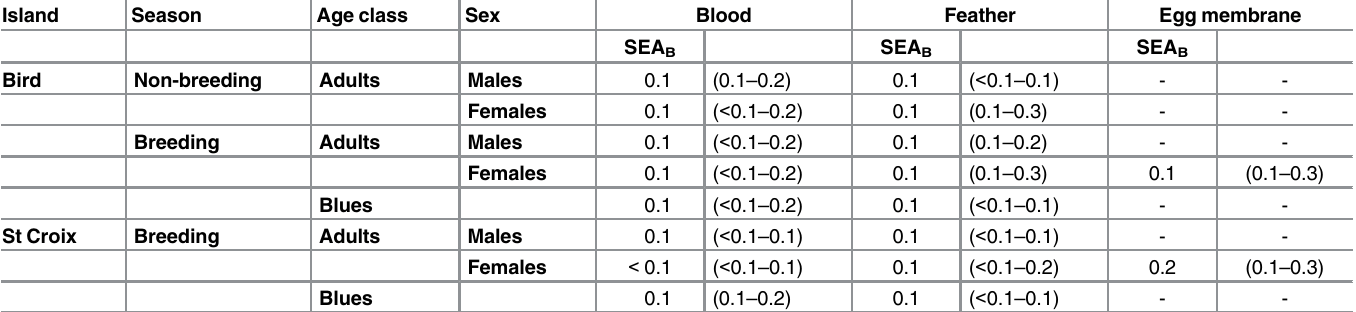
Table 3. Average standard ellipse areas ( ‰ ²) with 95% confidence intervals estimated from δ 13 C and δ 15 N values using a Bayesian Inference with 10,000 replications. Island